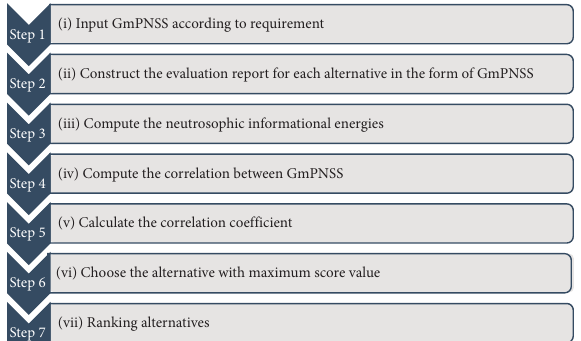
Figure 2: Flow chart of the presented algorithm based on the correlation